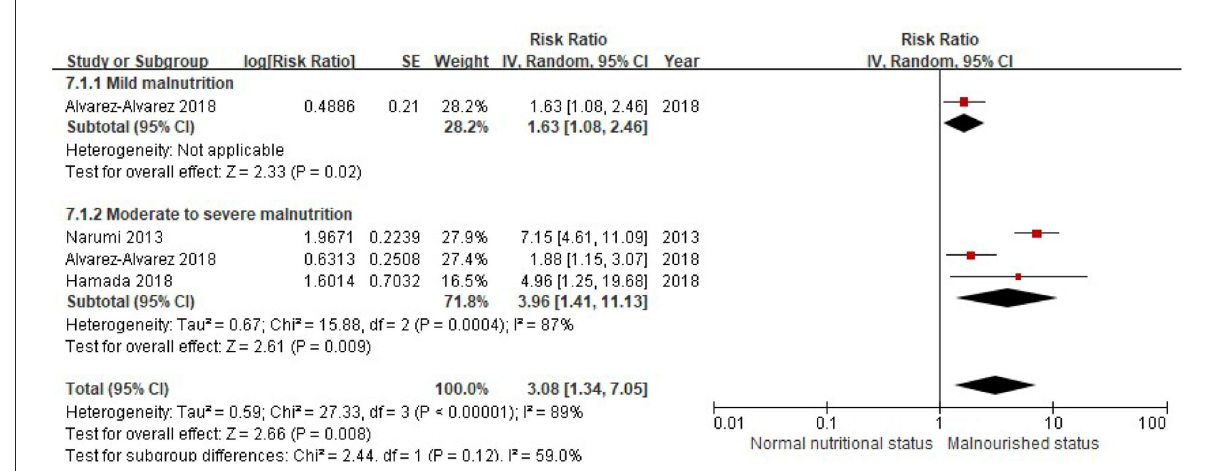
FIGURE7 A forest plot of comparison: MACEs in patients with HF associated with different levels of malnourished status defined by the CONUT score. CONUT, controlling nutritional status; HF, heart failure; MACEs, major adverse cardiac events.